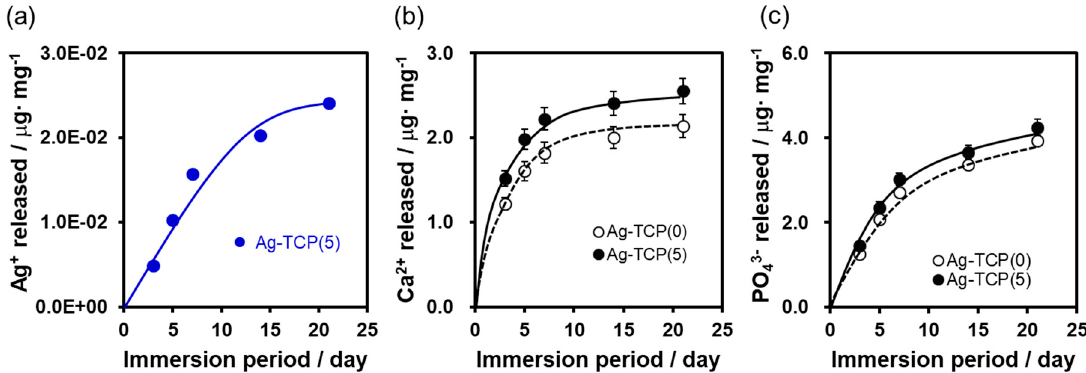
Figure 6. Release kinetics of Ag + , Ca 2 + , and PO 43 − ions from Ag-TCP cements. Release of Ag + ion ( a ), Ca 2 + ion ( b ), and PO 43 − ion ( c ) from Ag-TCP cements immersed into 4-(2-hydroxyethyl)-1- piperazineethanesulfonic acid (HEPES) buffer over time.